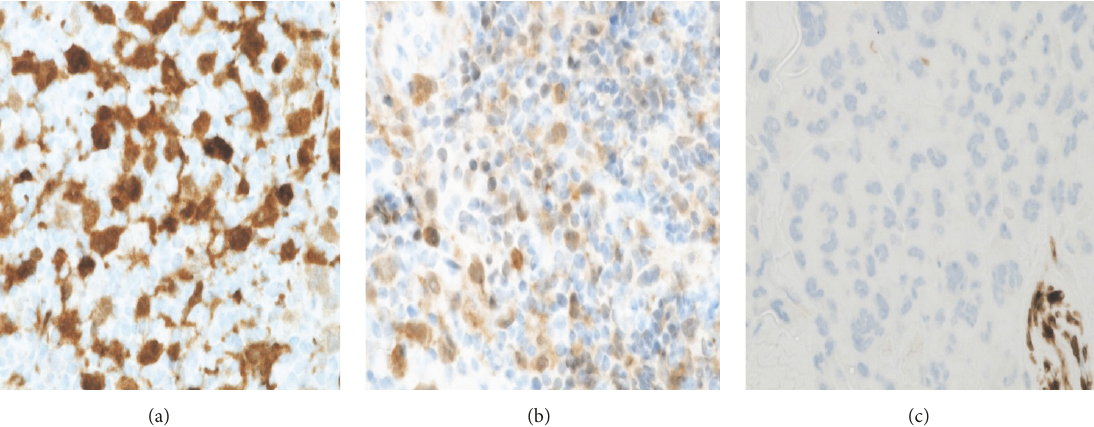
Figure 4: S100 immunohistochemistry positivity was variable in the three biopsies; these images compare the S100 positivity from the three different biopsy sites. (a) shows that tumour cells are S100 positive; (b) shows that occasional tumour cells are S100 positive; (c) shows that tumour cells are negative for S100. This variability within a single cutaneous lesion has not been reported within a single LCS lesion.